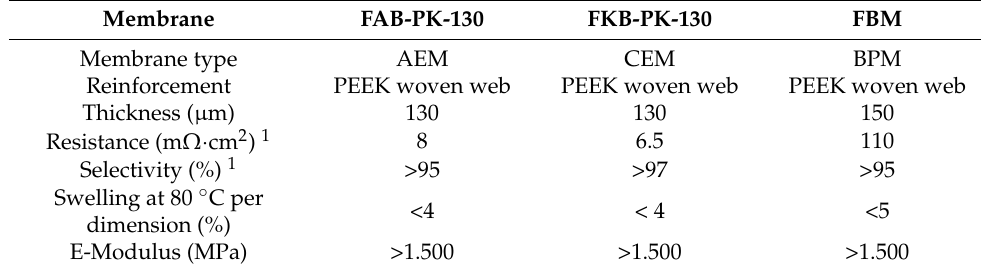
Table 1. Main properties of the FuMa ‐ Tech BWT GmbH membranes used [30].